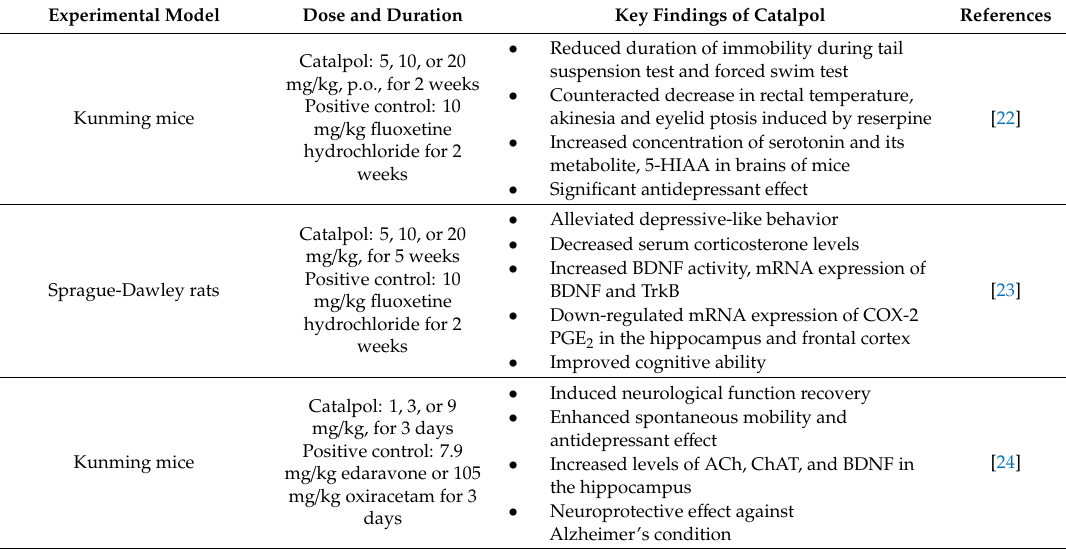
Table 2. E ff ect of catalpol in experimental models of neurological